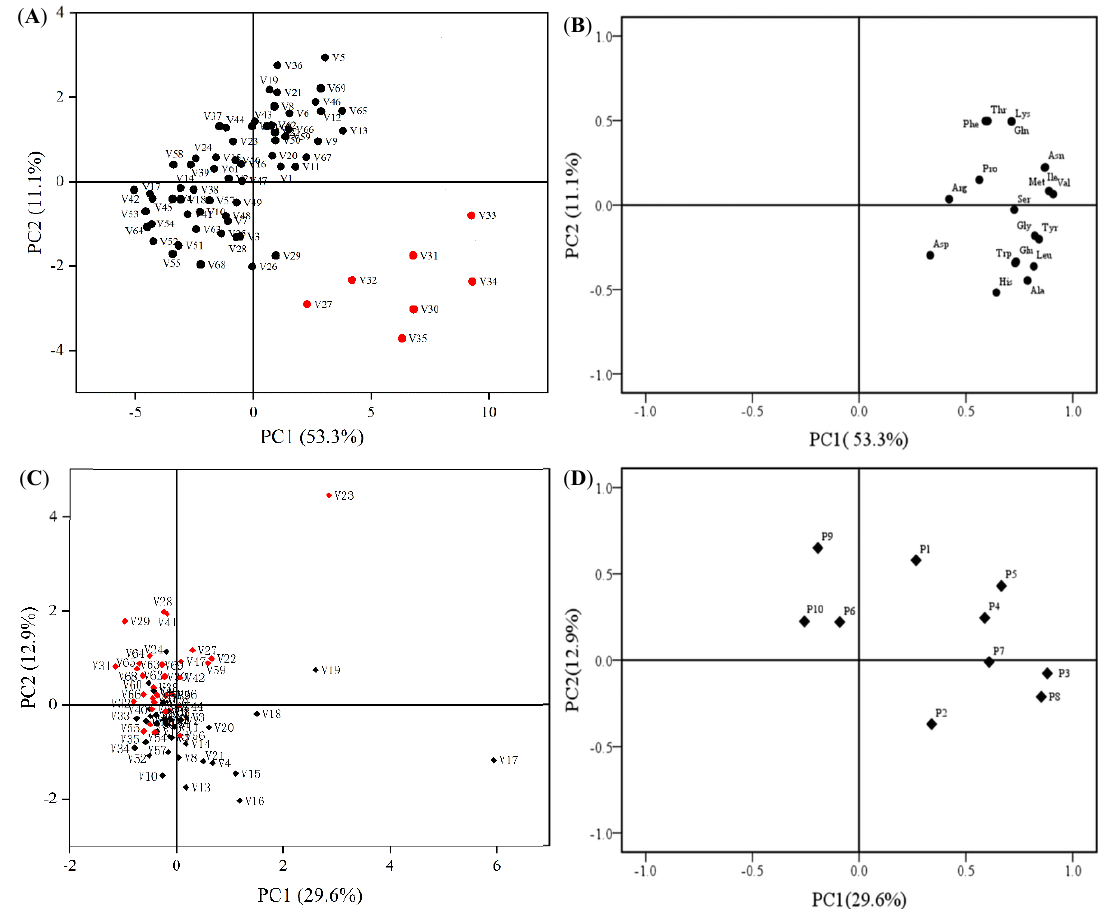
Figure 3. Principal component analysis (PCA) of 69 cabbage varieties and 19 free amino acids or 10 polyphenols. ( A ) shows the PCA scatter plot of amino acids. ( B ) shows a PCA loading plot of amino acids. ( C ) shows the PCA scatter plot of polyphenols. ( D ) shows a PCA loading plot of polyphenols. P1–P10 are defined in Figure 1.